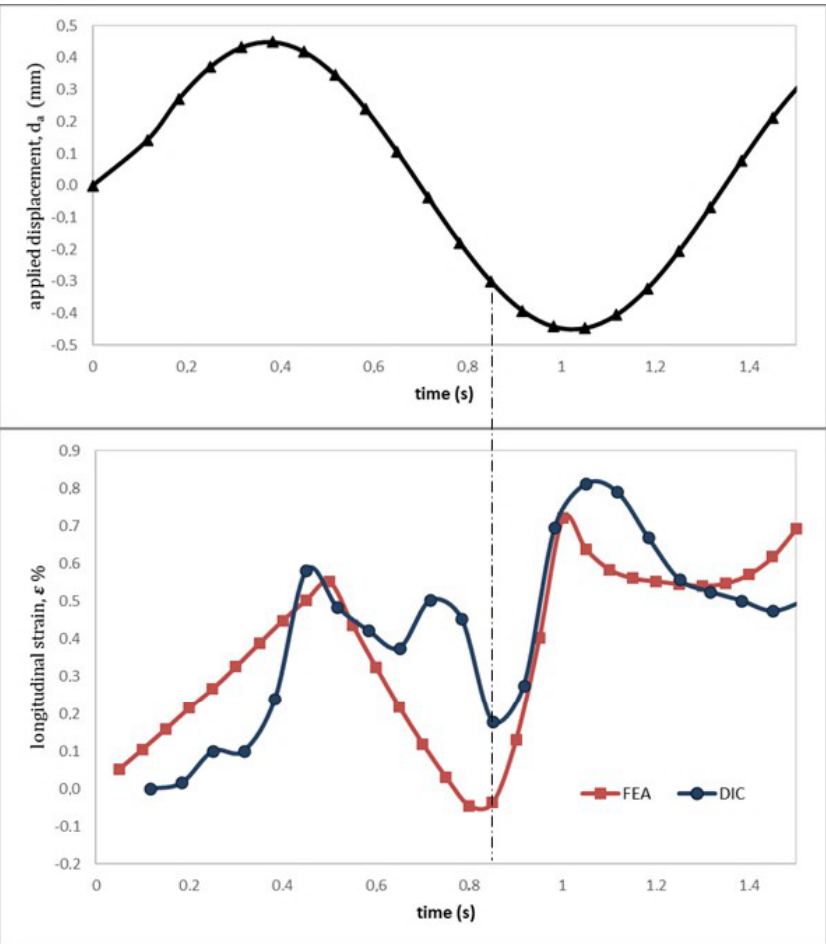
Figure 7. Strain values comparison between FEA and DIC.